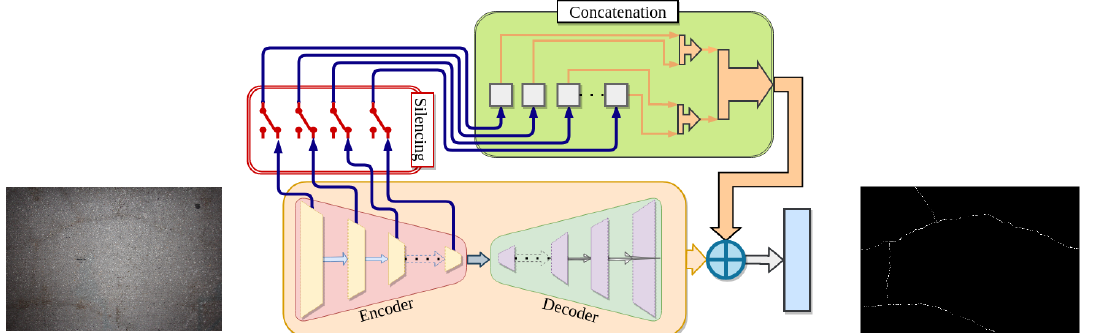
Figure 4. The proposed network architecture